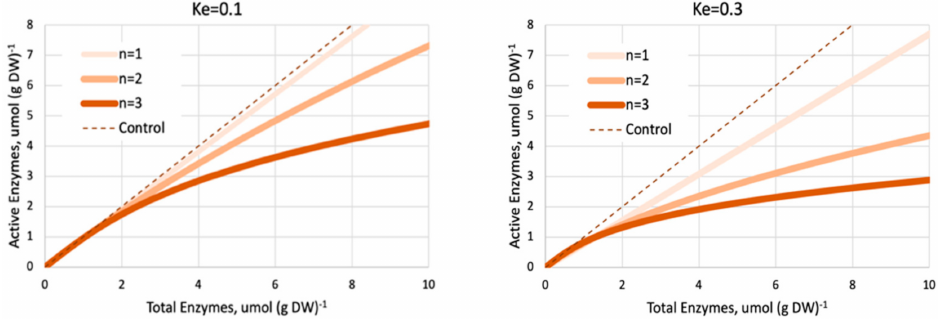
Figure A7. The modeling of the molecular crowding effect. The plots show progressive disparity between the active and total enzymes as the proteins’ concentration increases at two levels of K e = k 1 / k 2 and three levels of n , the kinetic order of the aggregation reaction. The dotted line stands for negative control, no